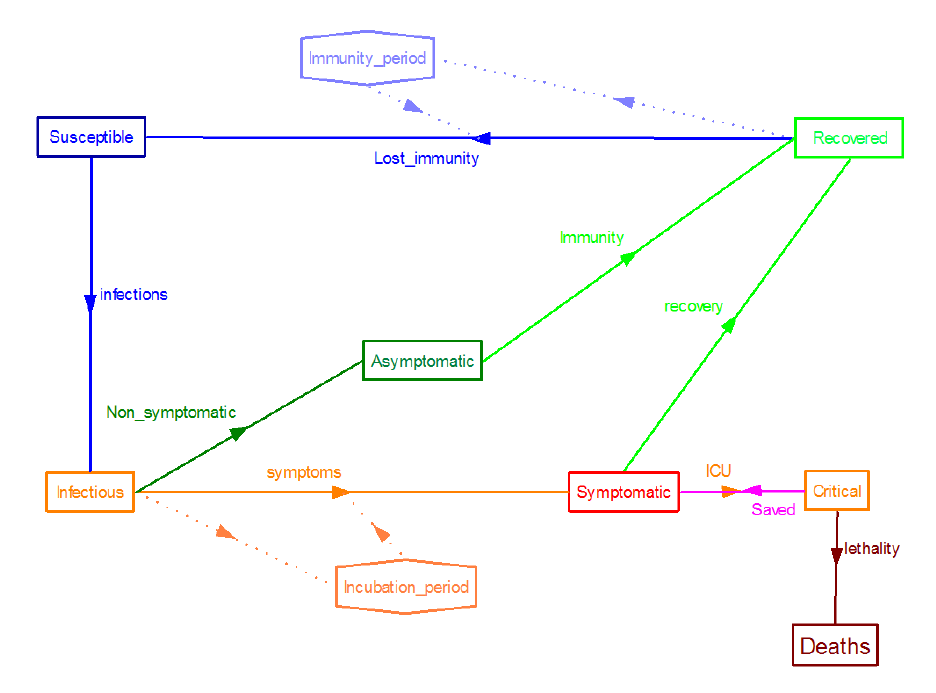
Figure 1. Example of a Susceptible, Infectious and Recovered (SIR) type compartment model adapted to simulate the behaviour of SARS-CoV-2. In this case we assumed that immunity would be lost in a given period of